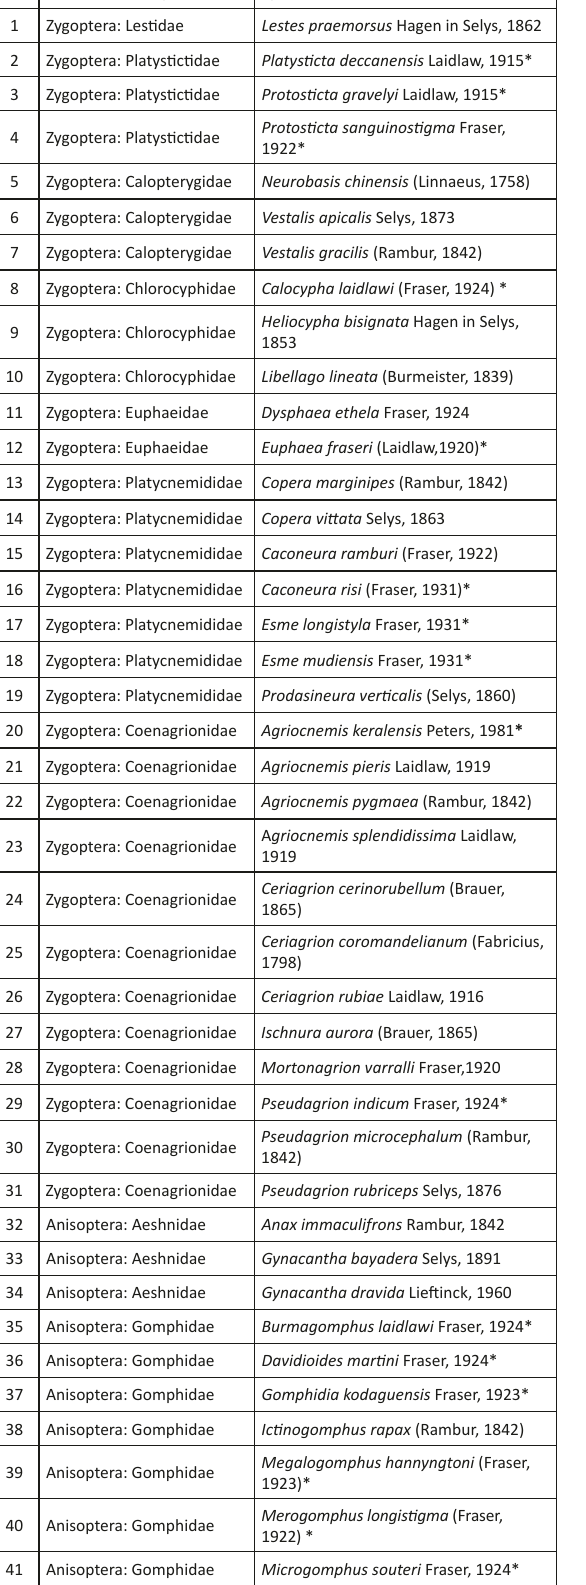
Table 1. Checklist of Odonata of Thattekkad Suborder: